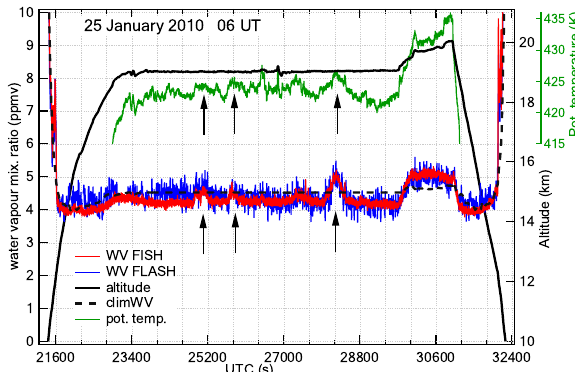
Fig. 5. Results of the aircraft flight on 25 January 2010 showing the rehydration signatures: time series of water mixing ratio mea- sured by FISH and FLASH-A (left axis); potential temperature (up- per right axis); altitude flight profile (right axis) and climatological mean water vapour for the given altitude (based on January mean water vapour from FPH and CFH soundings in 2002–2010, dashed black line, left axis). Tick marks on the horizontal axis correspond to 10min intervals. The black arrows point to regions with positive water vapour anomalies, associated with